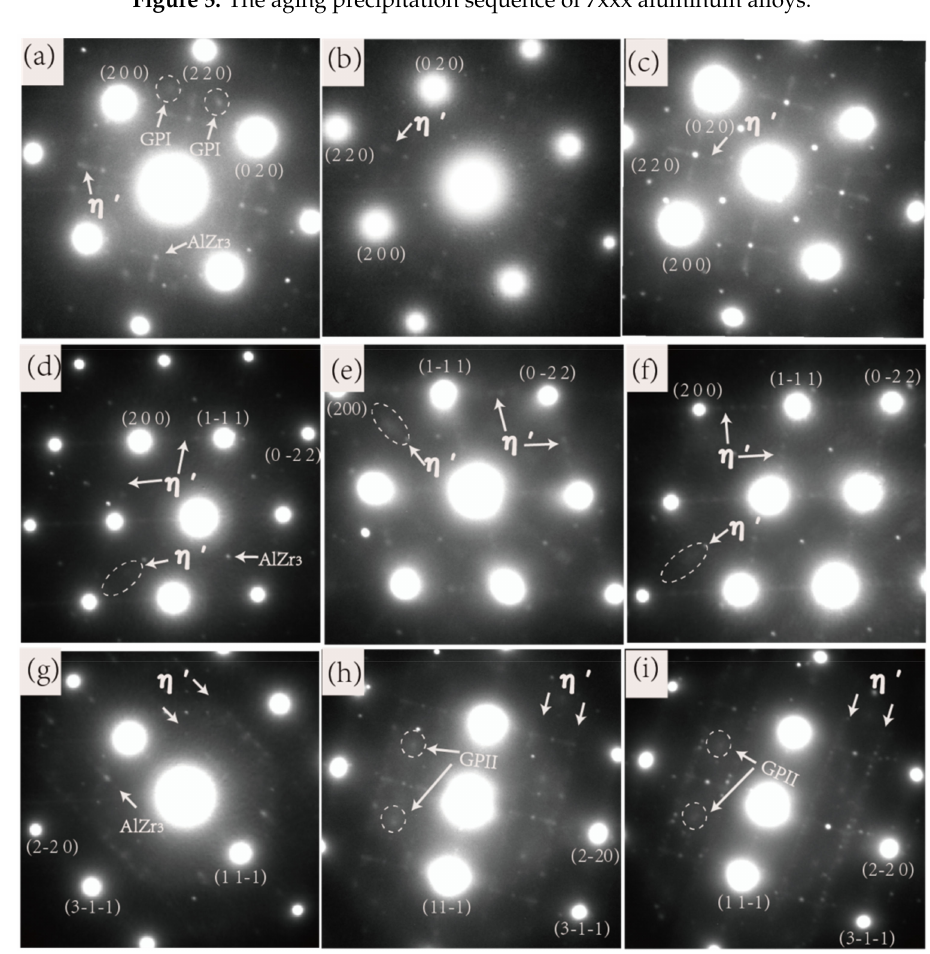
Figure 6. SAD (selected area diffraction) patterns of Alloy 1 aged for 61 h at 120 ◦ C: ( a ) <001> Al , ( d ) <110> Al , ( g ) <112> Al respectively; SAD patterns of Alloy 3 aged for 81 h at 120 ◦ C: ( b ) <001> Al , ( e ) <110> Al , ( h ) <112> Al respectively; SAD patterns of Alloy 5 aged for 90 h at 120 ◦ C: ( c ) <001> Al